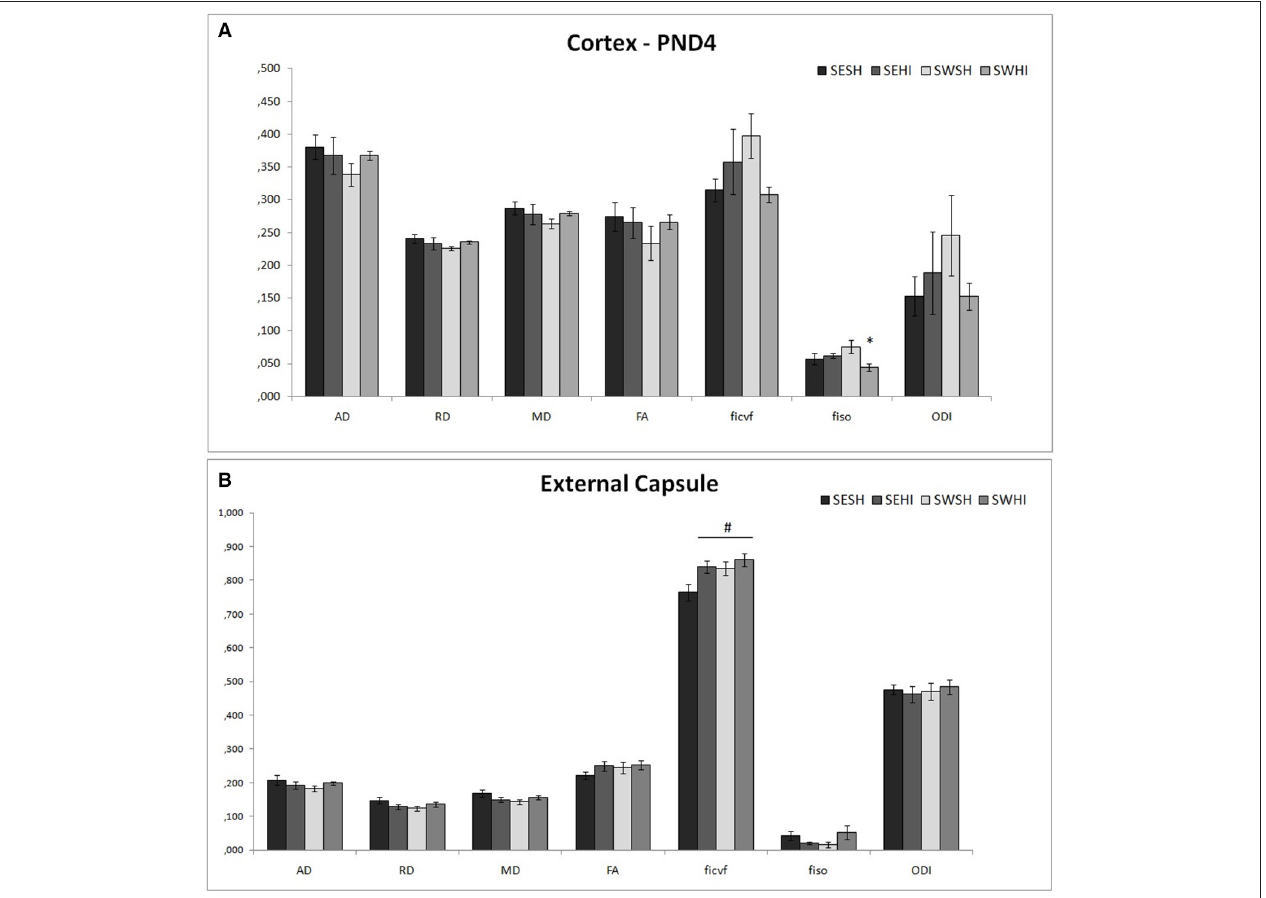
FIGURE 4 | DT-MRI microstructural white matter alterations at PND4. Histograms of mean values ± SEM of the DTI derived parameters at PND4 in the cortex (A) , and external capsule (B) . Axial Diffusivity (AD), Radial Diffusivity (RD), Median diffusivity (MD), fractional anisotropy (FA) and NODDI estimates: intraneurite volume fraction (f icvf ), cerebrospinal volume fraction ( f iso ) and orientation dispersion index (ODI) for SESH, SEHI, SWSH and SWHI groups. *SWHI vs. SWSH. # SESH vs. all other